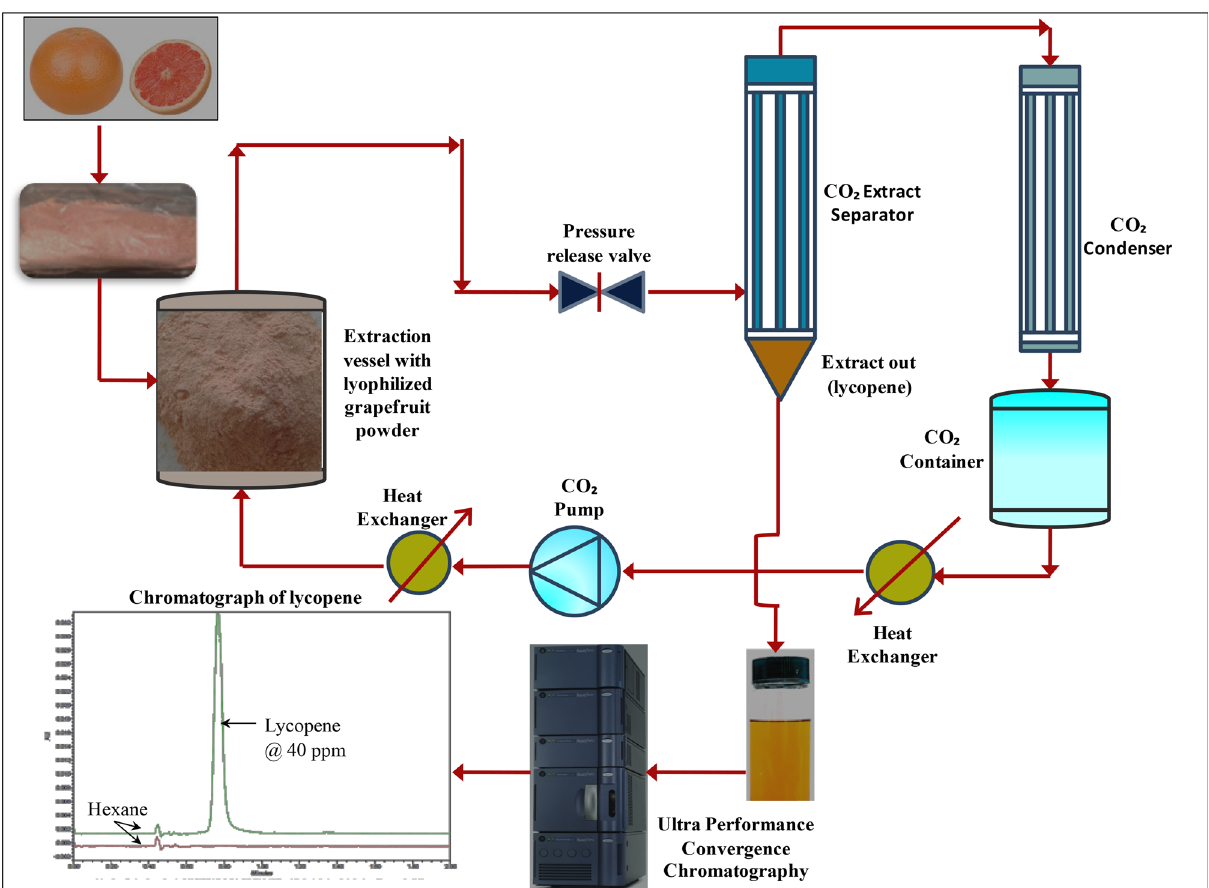
Figure 1. Schematic of the supercritical carbon dioxide extraction and characterization of lycopene from grapefruit.